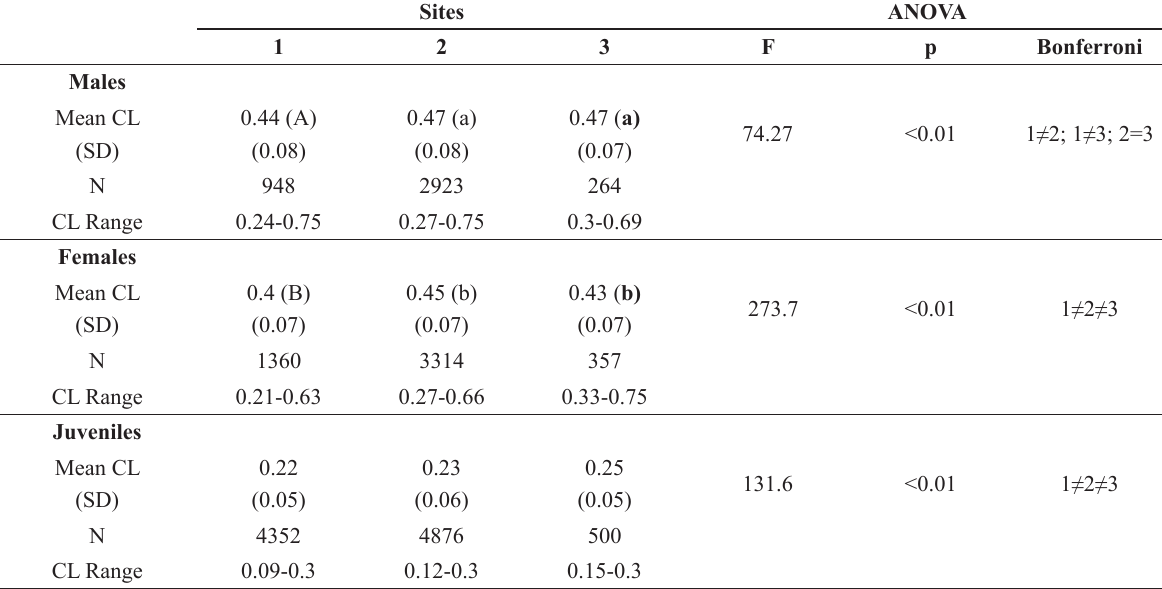
Summary of body size data of males, females and juveniles of H. pampeana and results of the Analysis of Variance (ANOVA) and a posteriori Bonferroni test (α=0.05) for the CL mean data recorded at sites 1 to 3. Annual mean CL (mm), standard deviation (SD), number of individuals (N) and CL range (minimum-maximum, in mm). Capital, small and bold letters show differences between mean CL of males and females at sites 1, 2 and 3,